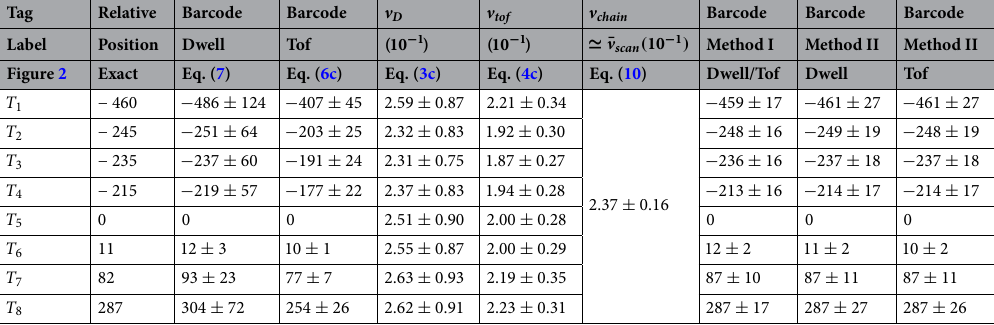
Table 2. Velocity to Barcodes using different